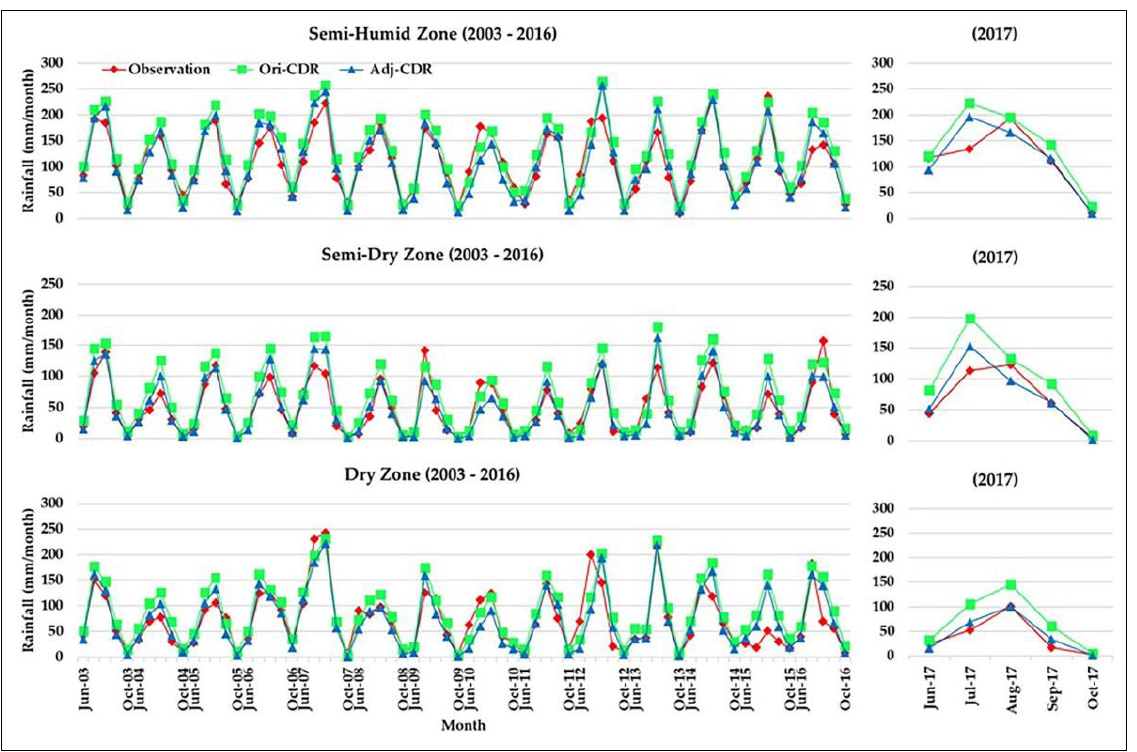
Figure 6. The areal mean monthly rainfall series for gauge observation, Ori-CDR, and Adj-CDR. In contrast, the CORRs of the areal mean monthly rainfall estimates for the semi-humid zone decreased, whereas those of the dry zone increased slightly. In contrast, the CORRs between the rain gauge observations and the adj-CDR displayed very high values, ranging from 0.87 to 0.94 during both periods of the overall